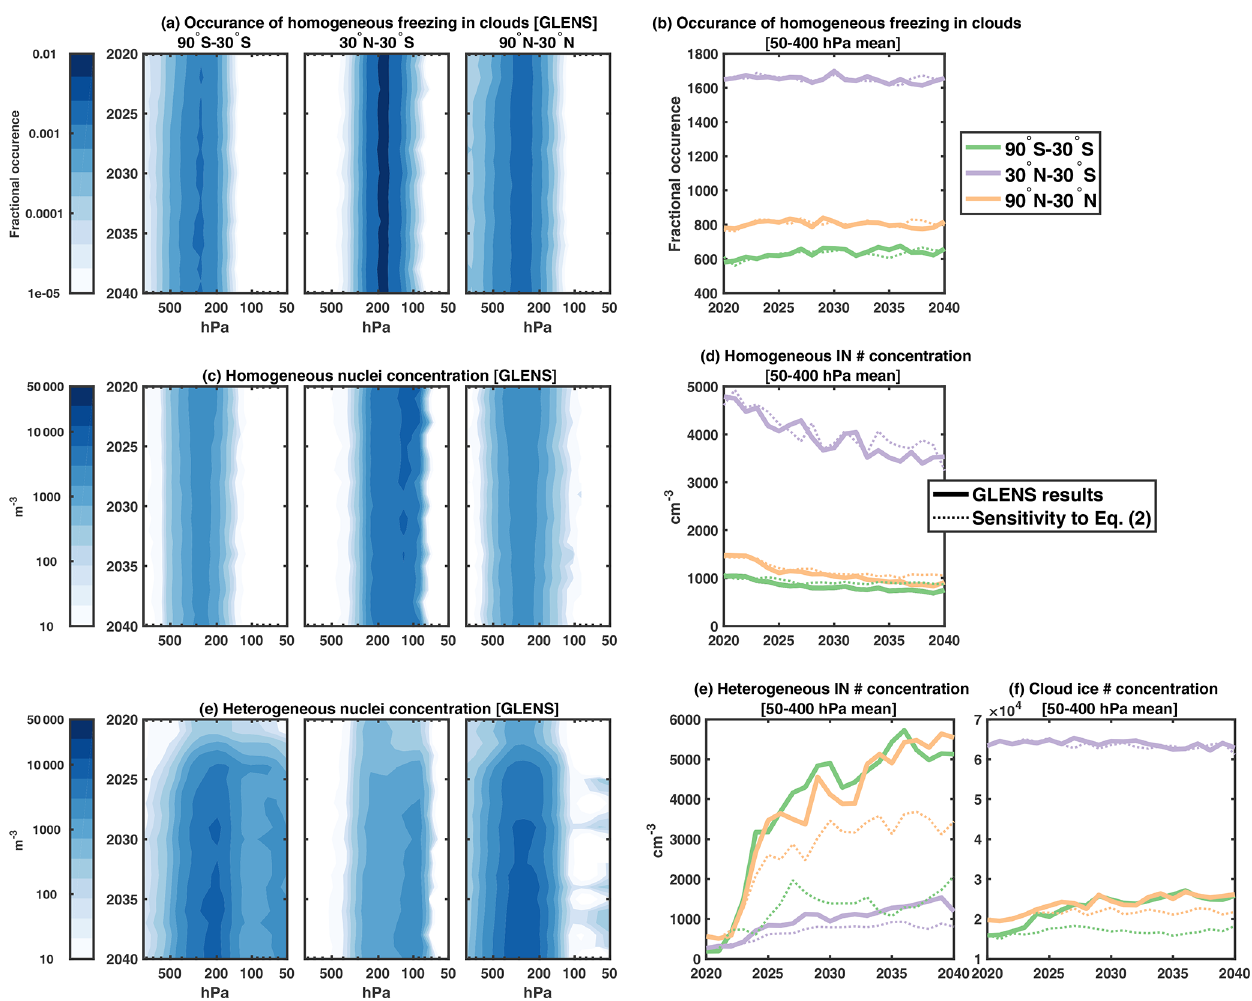
Figure 6. Evolution of the occurrence of homogeneous freezing in clouds (a) , the concentration of what the model considers to be IN for homogeneous freezing (Aitken mode sulfate) (b) and the concentration of IN for heterogeneous freezing (coarse mode dust) (c) in GLENS in the first 21 years of simulation, for the three latitudinal bands already considered in Fig. 5. On the right, a column mean of between 50 and 400hPa is considered (thick lines), together with the case described in the text with a sensitivity test for Eq. (2) (dotted lines). In panel (f) the ice number concentration shown in Fig. 5 is compared with that of the sensitivity